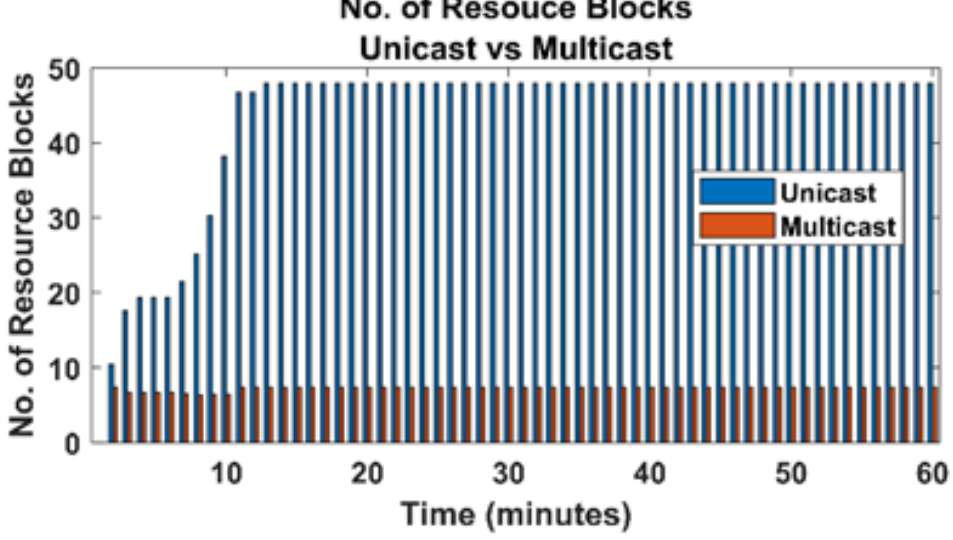
Figure 6. Resource blocks used (multicast vs.